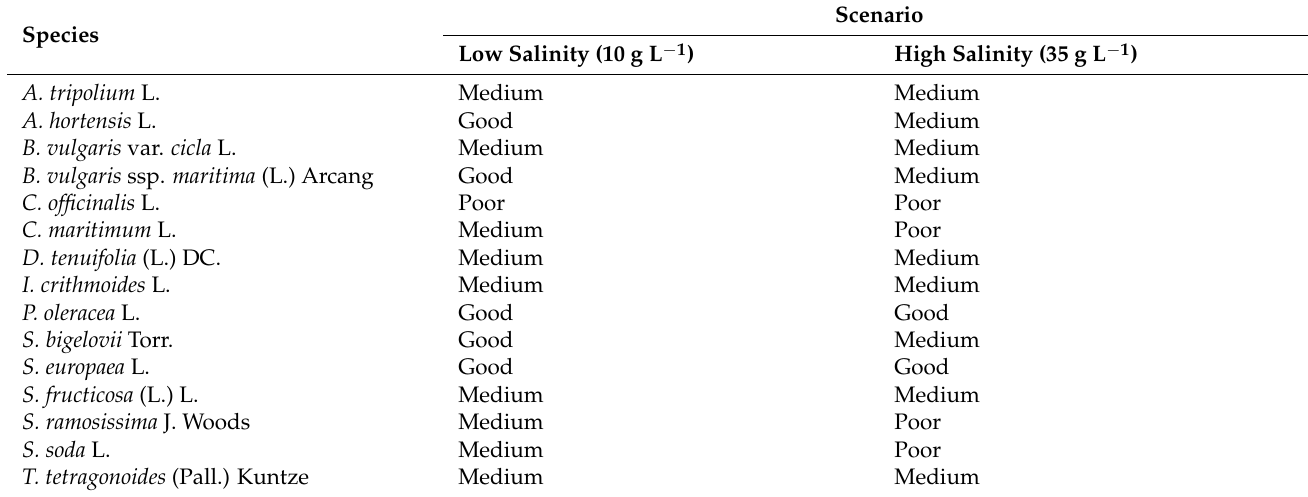
Bold letters indicate aggregated criteria or sub-criteria; grey highlighted rows indicate criteria; symbols means that a ‘plus/minus 1’ change in the indicator’s score affects the ‘Plant species selection’ value positively (+) or nega- tively ( − ); H: High, M: medium, and L: Low for criteria score; G: Good, M: Medium, P: Poor, and U: Unacceptable. Table 10. Final score for the considered plant species in two scenarios using DEXi